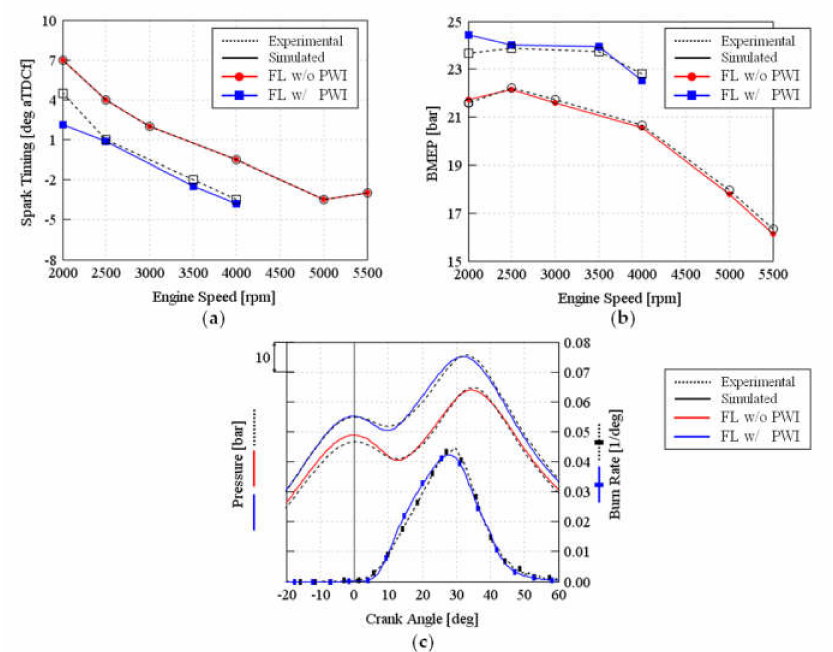
Figure 13. Experimental (dotted lines) and simulated (solid lines) without PWI (red lines) and with PWI (blue lines) at Full Load (FL) operating conditions: ( a ) Spark Timings vs. engine speed; ( b ) BMEP vs. engine speed; ( c ) in-cylinder pressure (left axis) and burn rate (right axis) vs. crank angle at 4000 rpm.